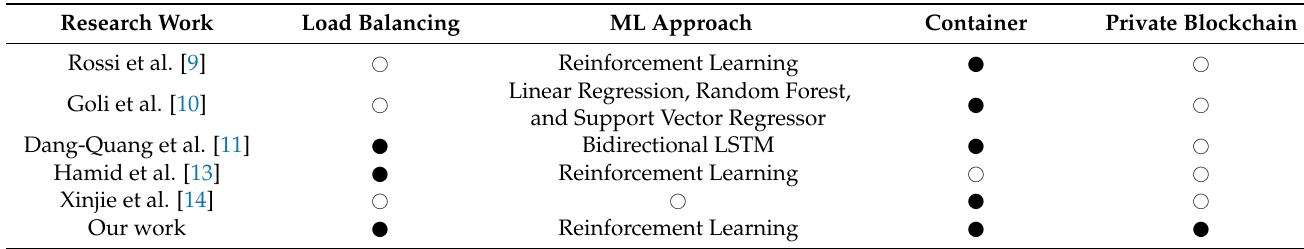
Table 5. Comparative analysis of existing works with the proposed